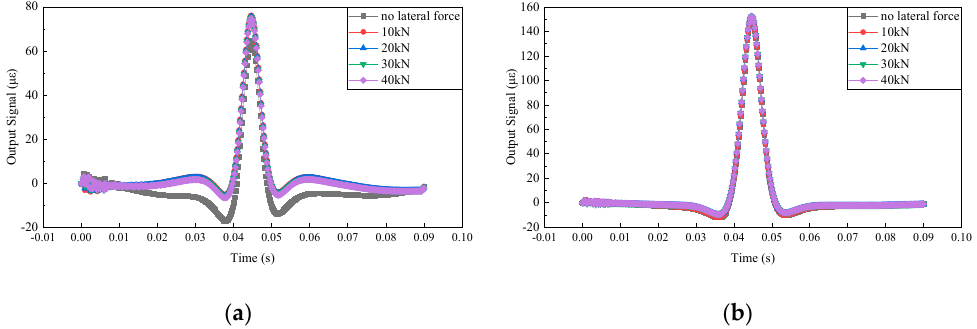
Figure 8. Comparison of influences of lateral forces on different layout schemes: ( a ) Rail web bending moment method; ( b ) rail web compression method.